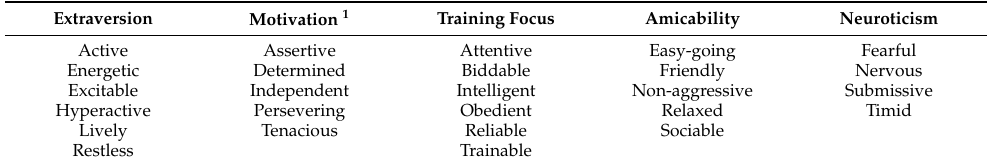
Table 1. Descriptive words used in the MCPQ-R and the label of their underlying dimension. Scores for the items under each label were averaged to produce an overall score.